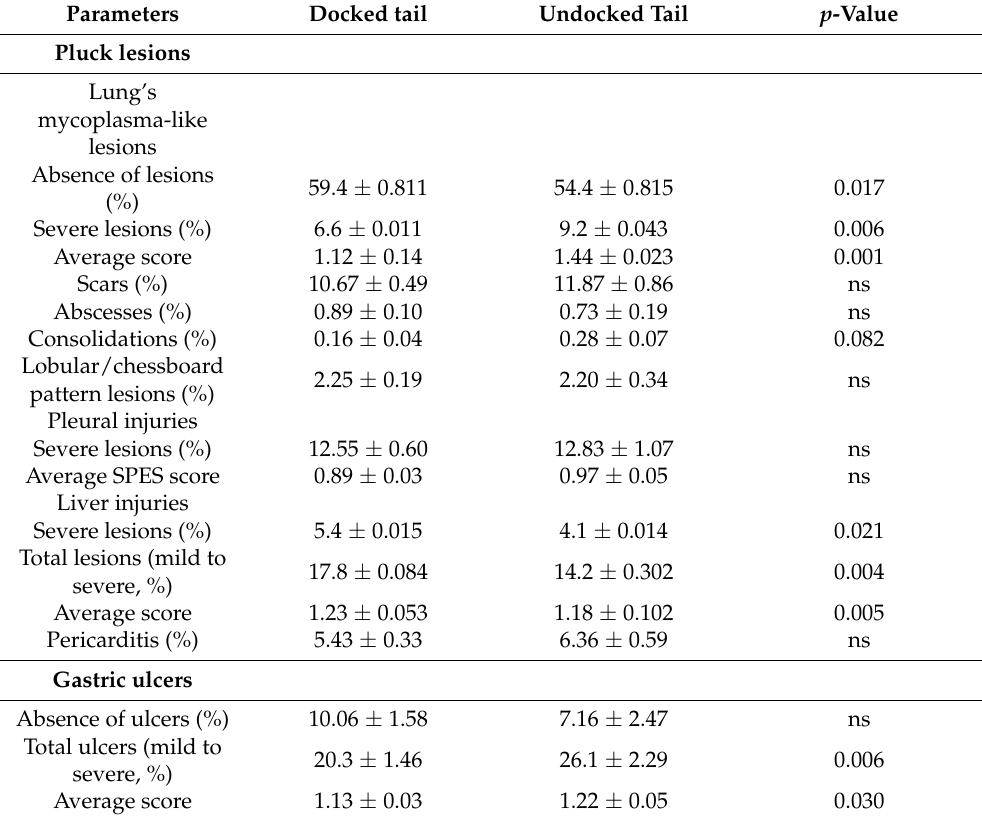
Table 3. Average percentage of lesions ( ± standard error) observed in different organs of the pluck (lungs, pleurae, liver, heart) and gastric ulcers. Only p -values lower than 0.090 are reported. Parameters Docked tail Undocked Tail p